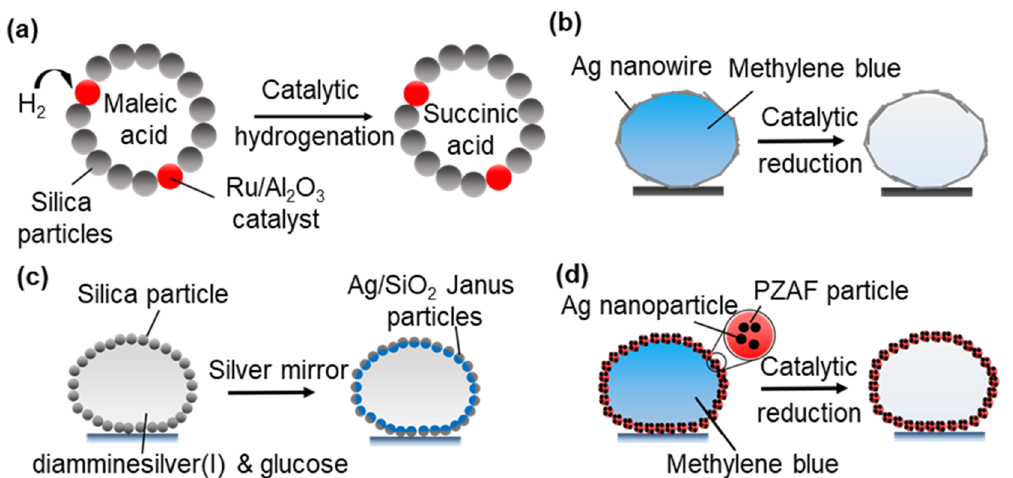
Figure 5. Reactions in catalytic liquid marble-based microreactors. ( a ) Hydrogenation of maleic acid in dry water with a Ru / Al 2 O 3 catalyst [67]. ( b ) Reduction of methylene blue in catalytic liquid marbles covered by silver nanowires [68]. ( c ) Silver mirror reaction and Janus particles synthesised with silica-based liquid marbles [69]. ( d ) Catalytic reduction of methylene blue in liquid marbles covered by silver nanoparticle-decorated poly(cyclotriphosphazene-co-4,4 (cid:48) -(hexafluoroisopropylidene)-diphenol) particles (Ag / PZAF) [71].